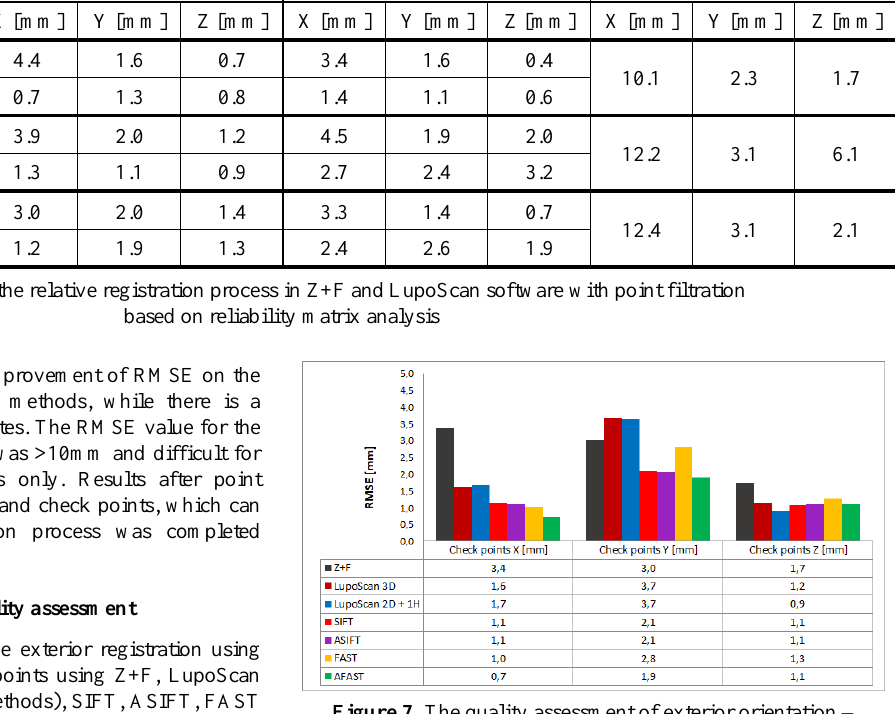
Figure 7. The quality assessment of exterior orientation – RSME on marked check